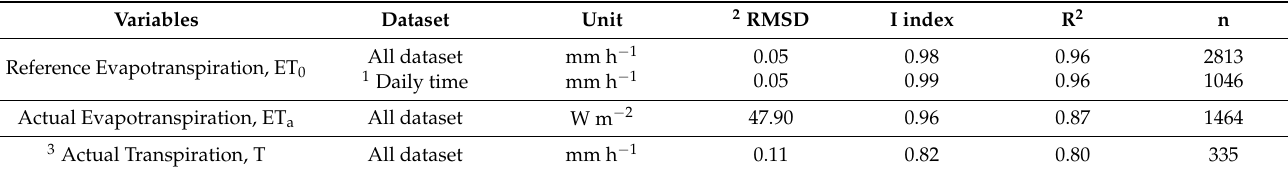
Figure 2. Similarity of simulations of reference evapotranspiration (ET 0 ) by the Penman–Monteith approach by the Food and Agriculture Organization (FAO-PM) and the reference soil–plant–atmosphere continuum (R-SPAC) model. Table 1. Statistical summary of the performance of the reference soil–plant–atmosphere continuum (R-SPAC) model in simulating reference evapotranspiration (ET 0 ) and associated SPAC in simulating actual evapotranspiration (ET a ) and its partitioning for actual transpiration (T). Variables Dataset